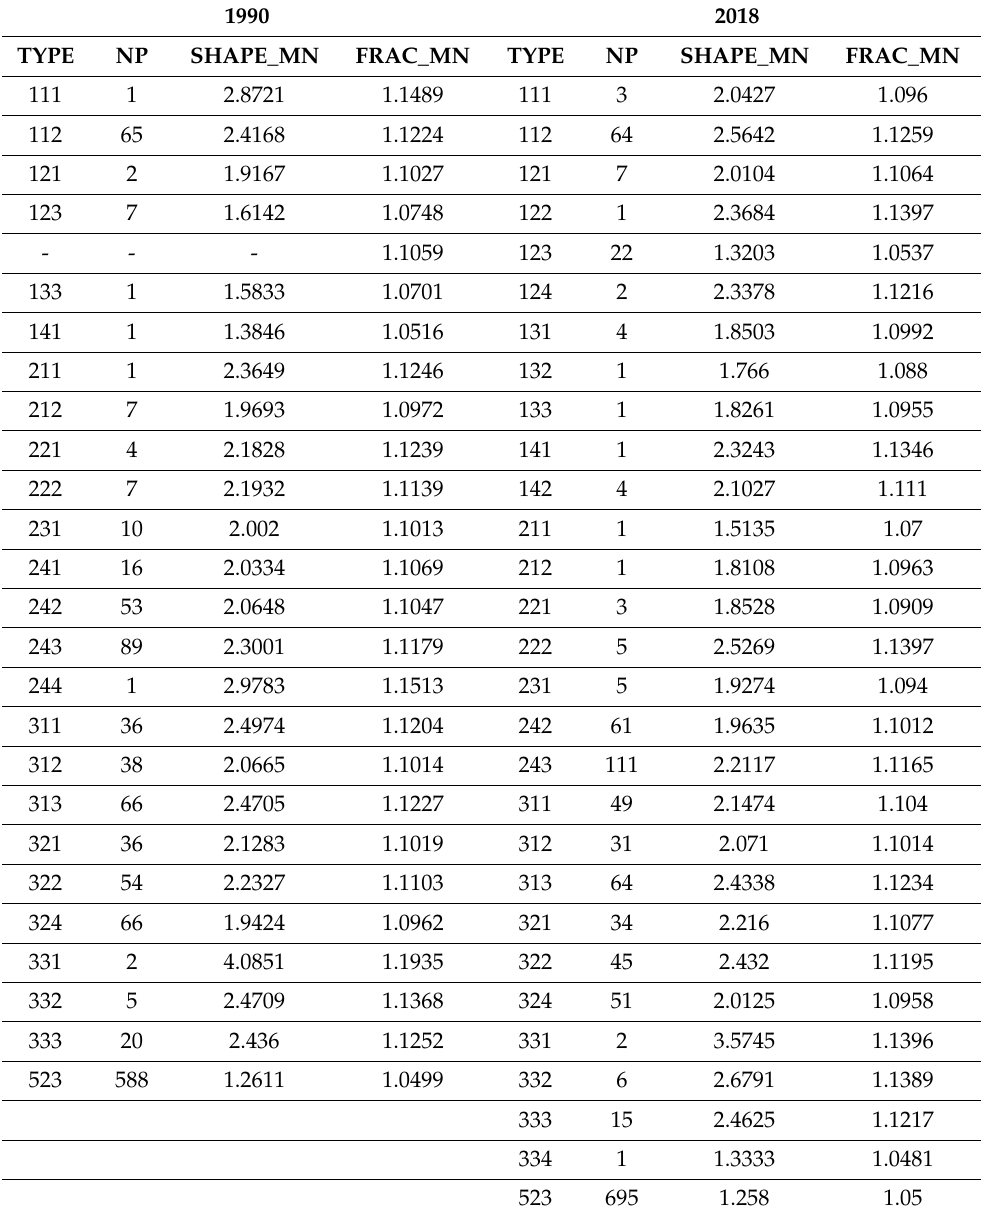
Table 12. Class metrics for the Autonomous Region of